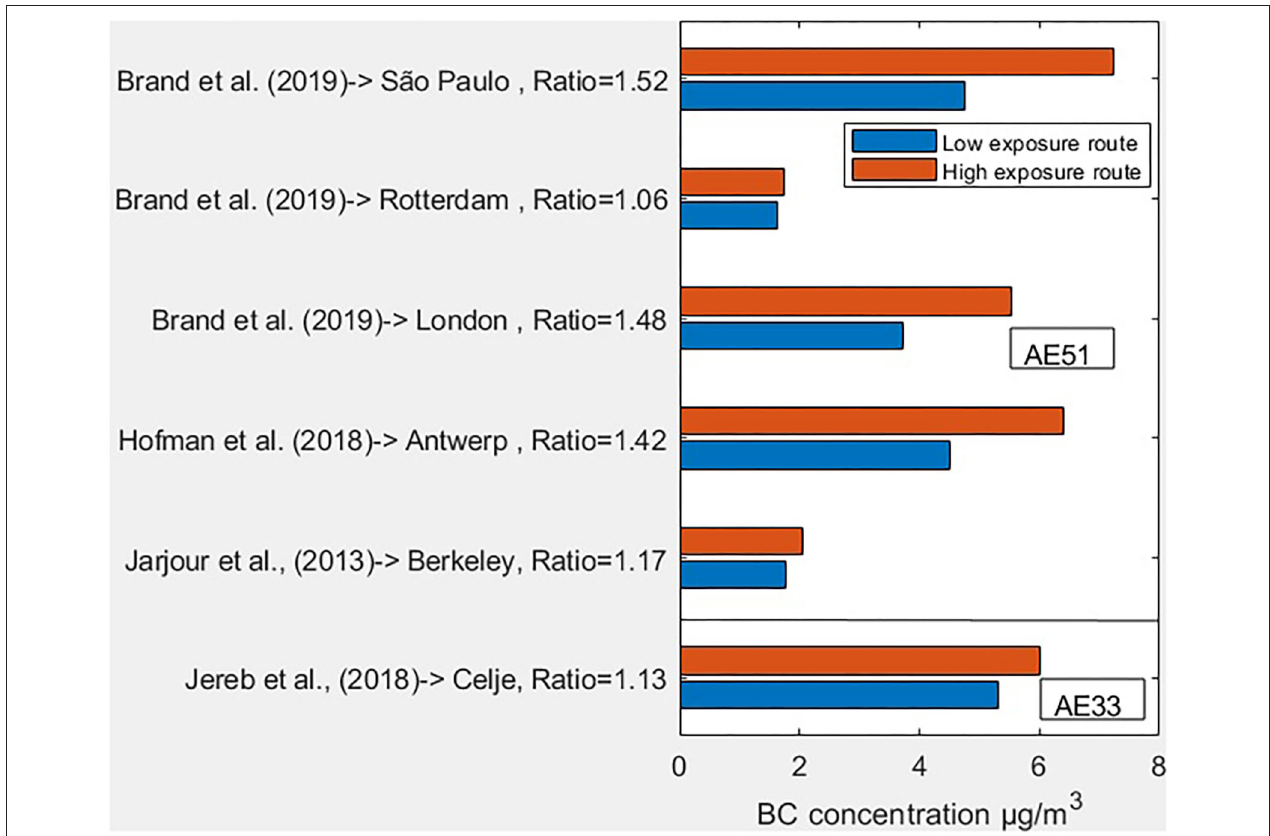
FIGURE 3 | Comparison of low and high exposure routes in different cities. The blue bar shows the mean of the low exposure route. The high exposure route is illustrated in orange color. Brand et al. (2019) measured BC exposure for the cyclist in three routes in three different cities. We used the mean of three low exposure and three high exposure routes for each